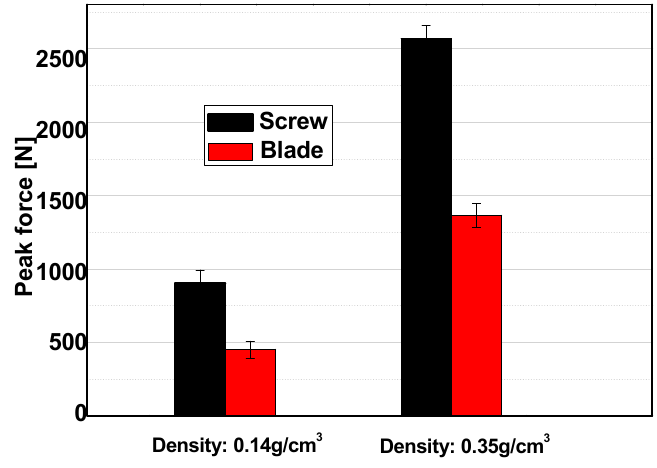
Figure 7. Comparison of peak force in pull-out test.